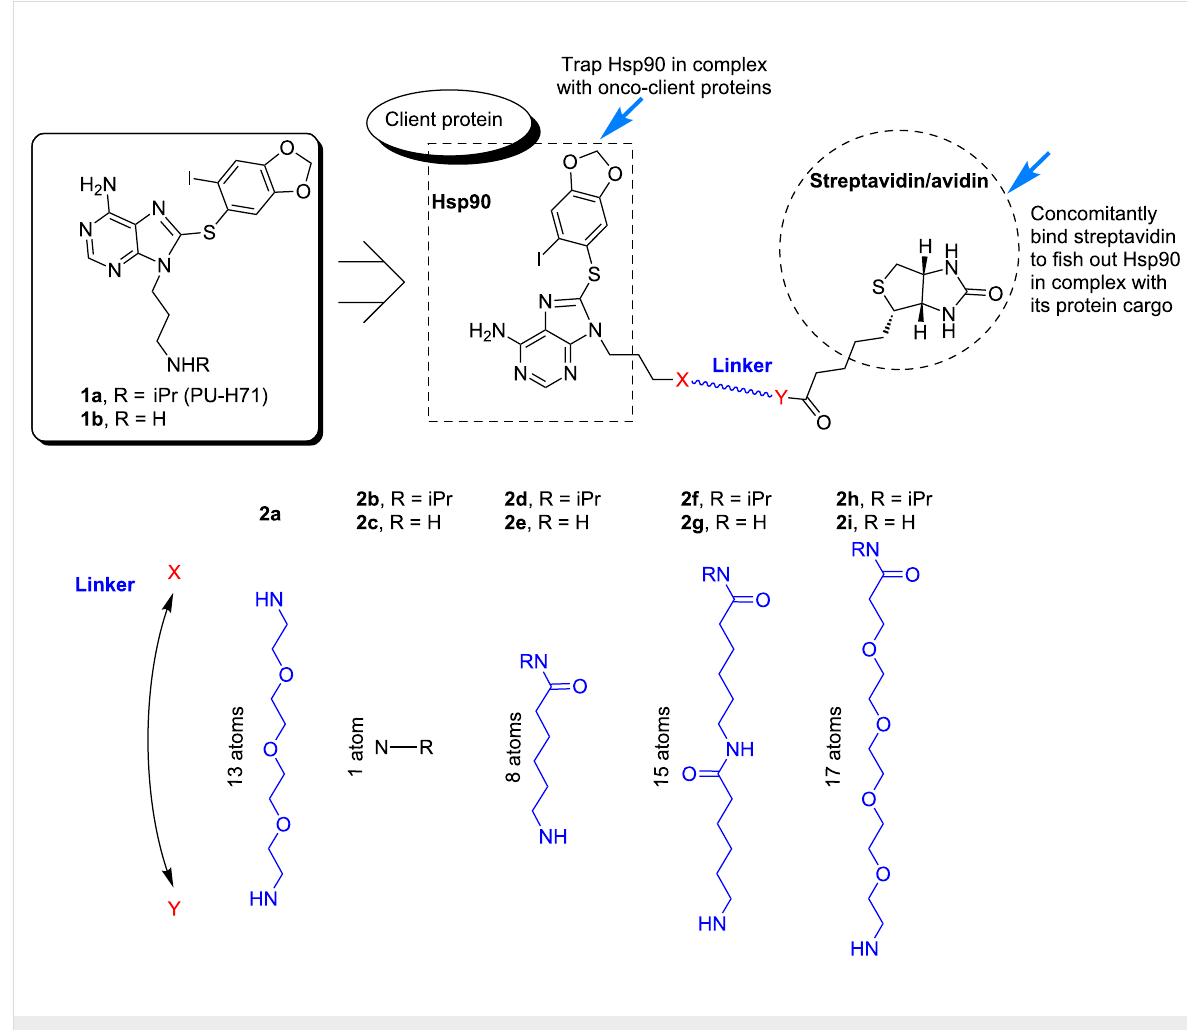
Figure 1: Design of the biotinylated Hsp90 probes based on PU-H71 ( 1a